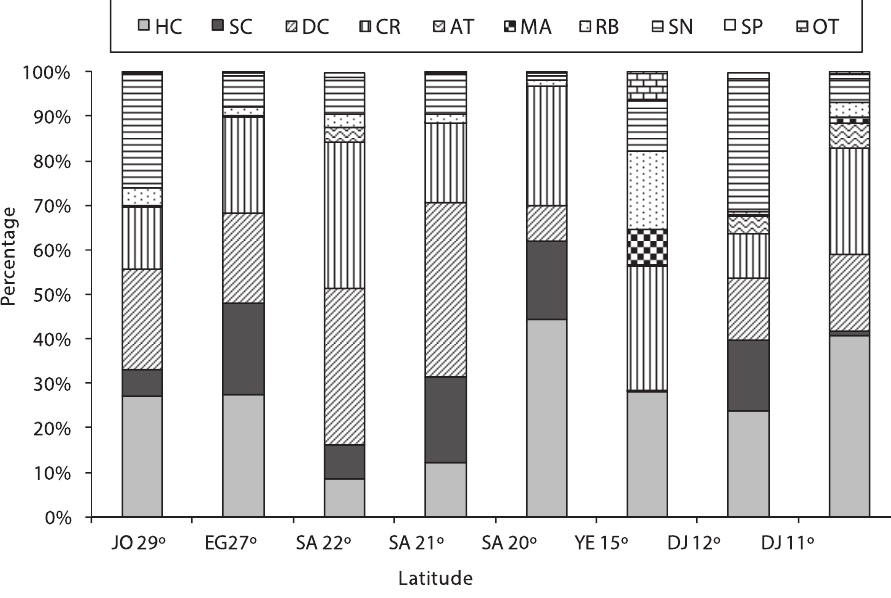
Figure 2. Percent cover (%) for substrate types at all latitudes [(JO=Jordan, EG=Egypt, SA= Saudi Ara- bia, YE=Yemen, DJ=Djibouti), where (HC=Hard coral, SC=Soft coral, DC=Dead coral, CR=Coral rock, AT=Algal turf, MA=Macroalgae, RB=Rubble, SN=Sand, SP=Sponge,